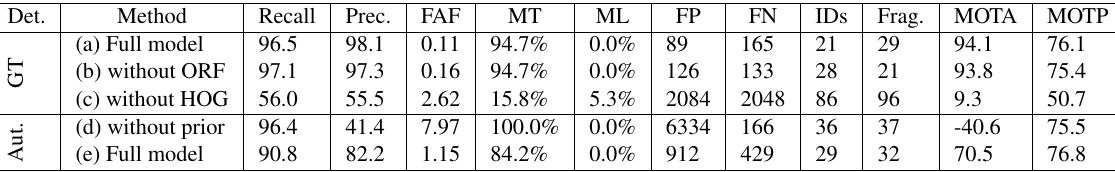
Table 2. Sensitivity study in